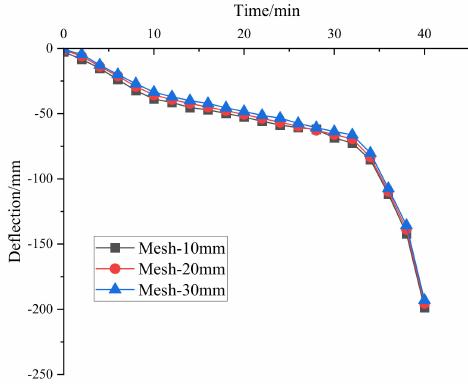
Figure 3. Three types of meshing details.